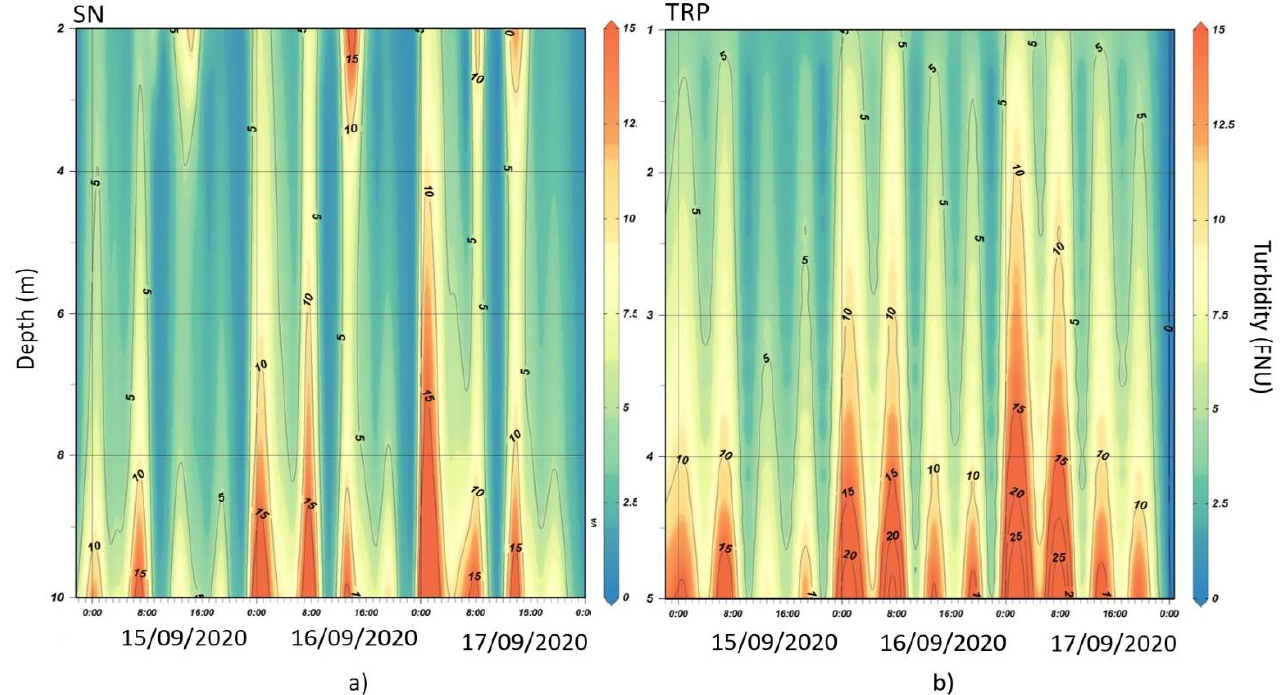
Figure 15. Time series of turbidity derived from acoustic backscatter of the two bottom-mounted ADCPs along the water column for the three-day test-period: ( a ) SN and ( b ) TRP. The y-axis scale is set according to the different depths of the two channels. Plot generated with Ocean Data View software (https://odv.awi.de, 2021 accessed on 12 July 2022).